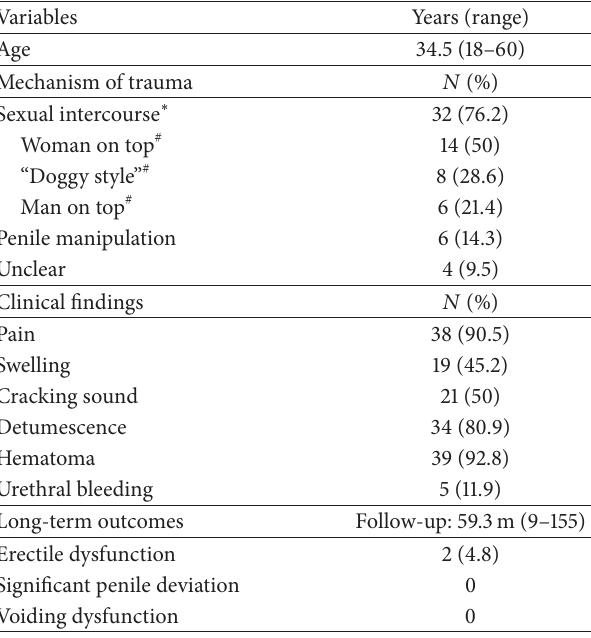
Table 1: Patients